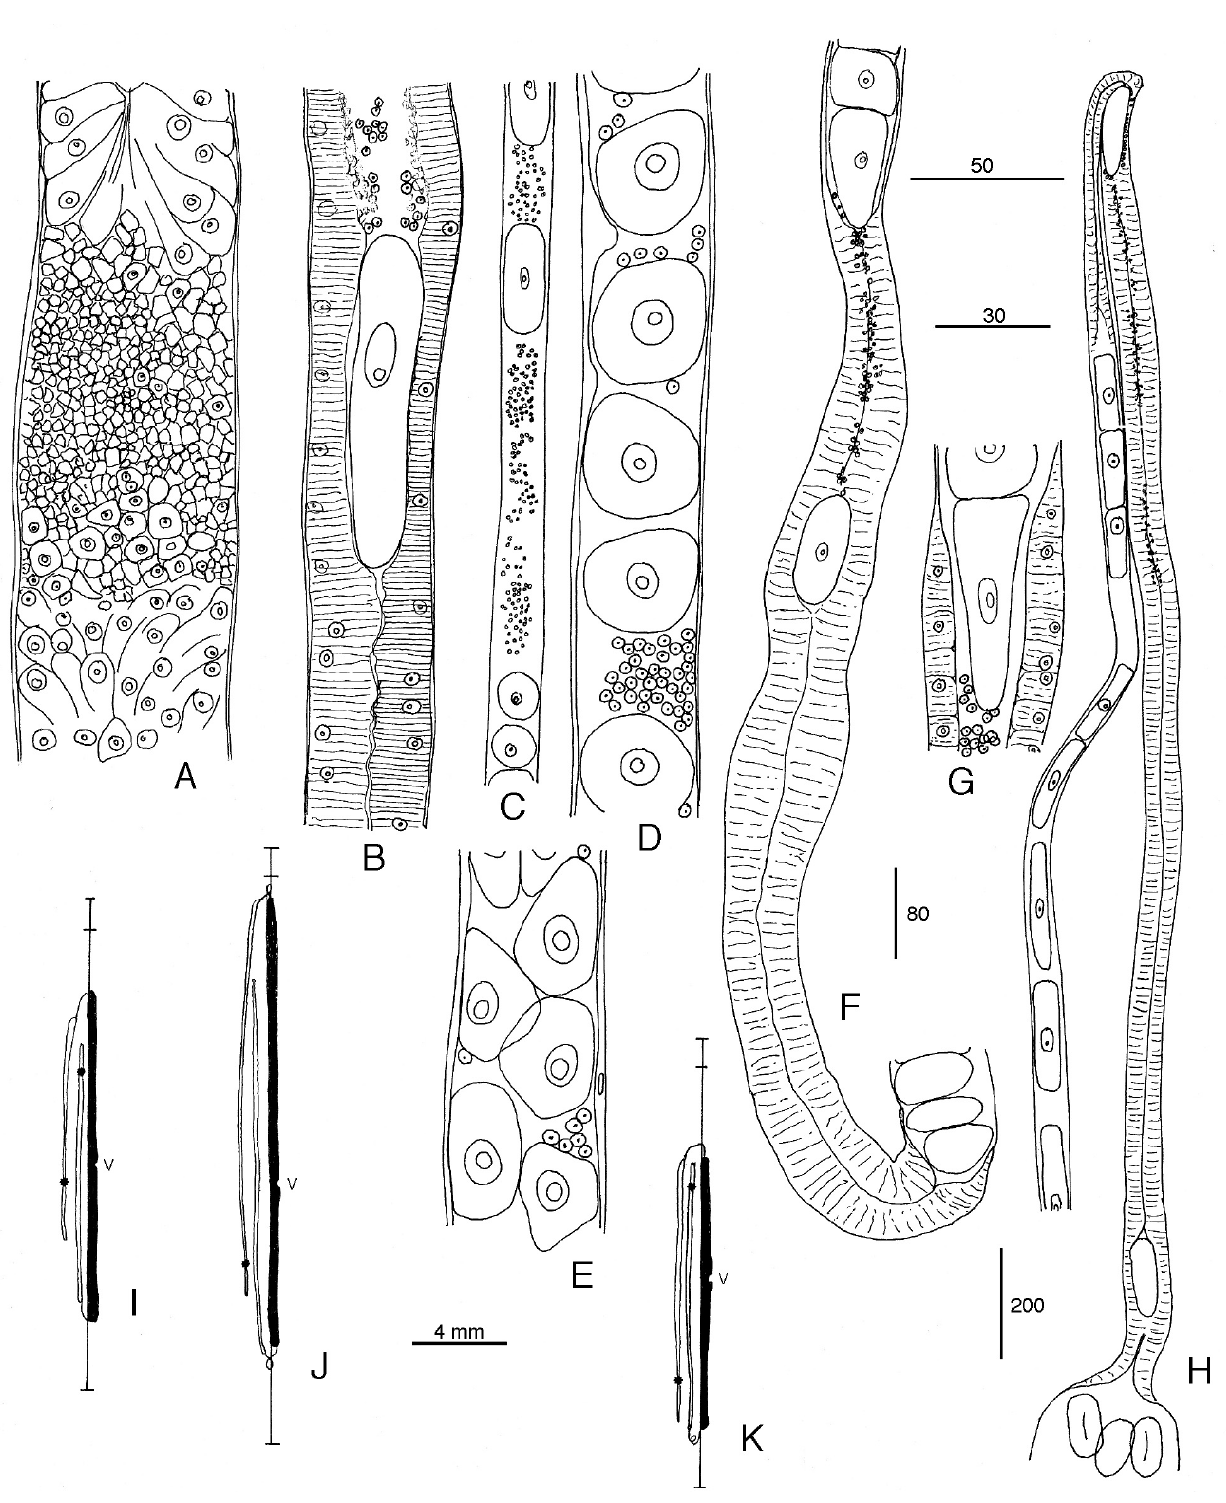
holotype. F. Posterior oviduct with spermatozoa, paratype. G. Detail of ovary-oviduct junction with ovulae and spermatozoa, another para- type. H. R. brevicorne n. sp., anterior oviduct with spermatozoa and junction with ovary and uterus, respectively, holotype. I-K. Schematic representation of females and extension of genital tract. I. R. rabetafikae n. sp. J. R. brevicorne n. sp. K. R. nasutum n. sp. v: Vulva. *: Posi- tion of male area in ovary. Scales in µm, unless otherwise indicated: A, B, D, E, 50; C, F, 80; G, 30; H, 200; I, J, K, 4